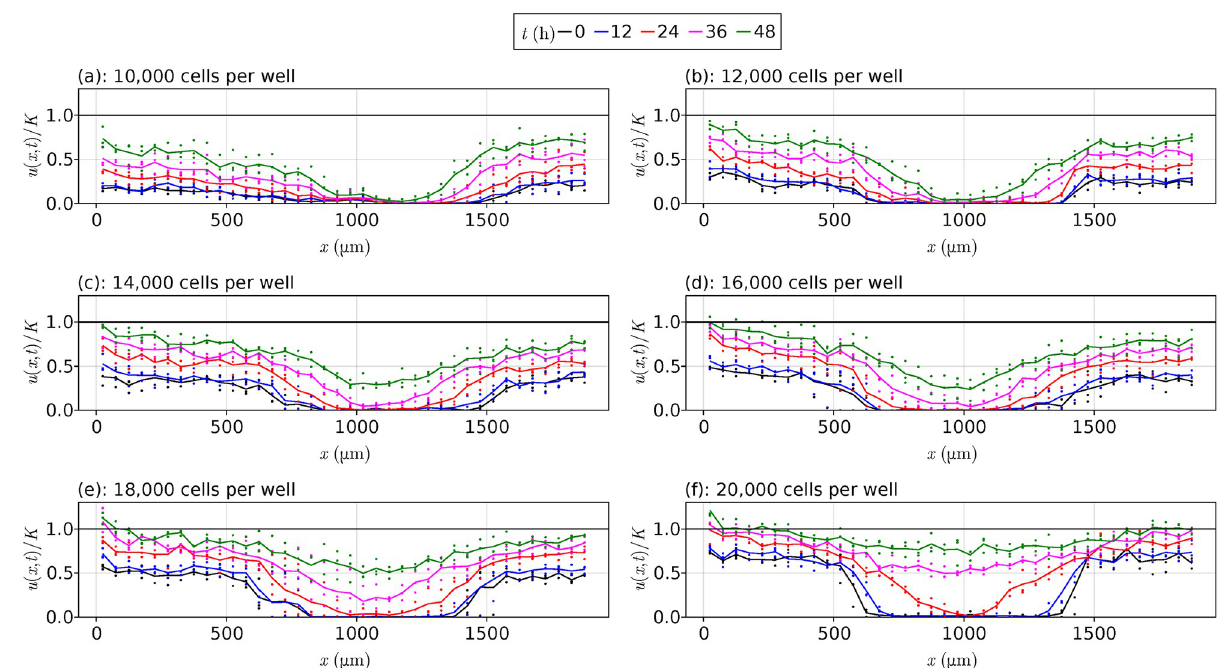
Fig 3. Scratch assay data. Scratch assay data from Jin et al. [13] for each initial cell density, with the vertical axis given by u / K rather than u , where K = 1.7 × 10 − 3 cells μ m − 2 . In each plot, the points represent experimental observations, and the continuous lines represent averaged values at each time over the three replications. The black horizontal lines are at u / K = 1.